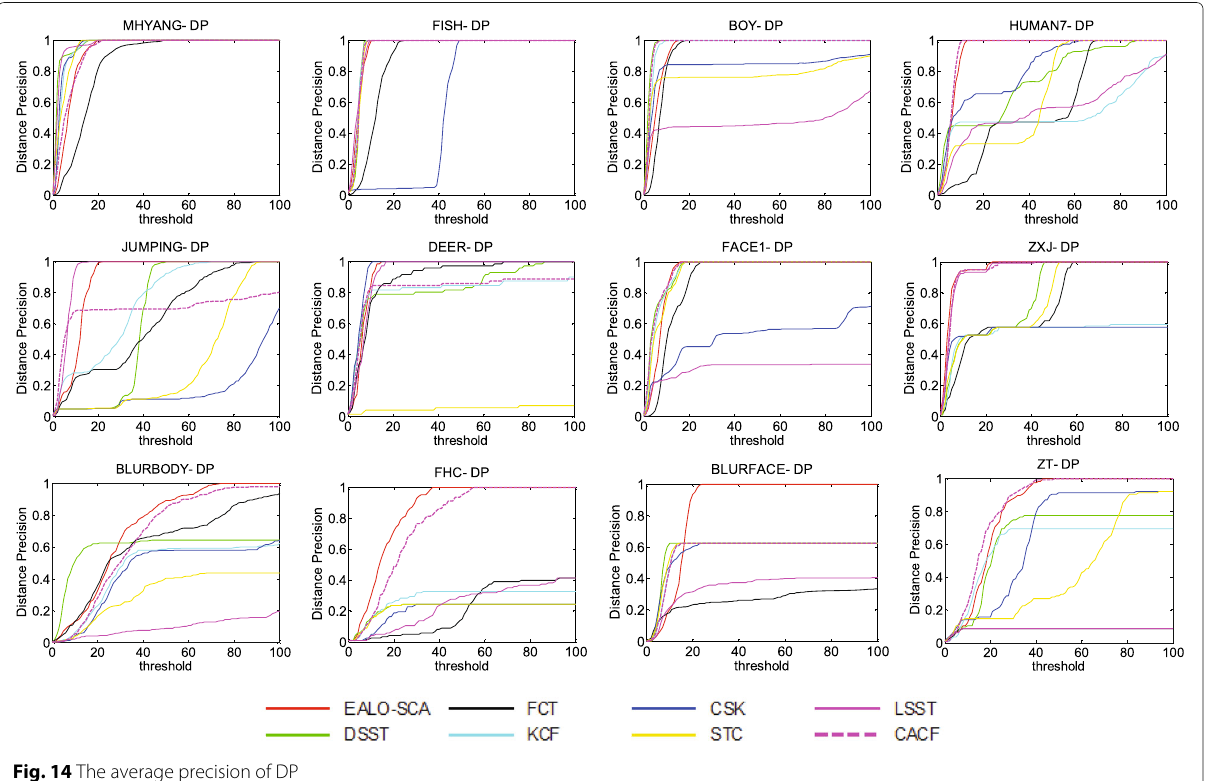
Fig. 14 The average precision of DP